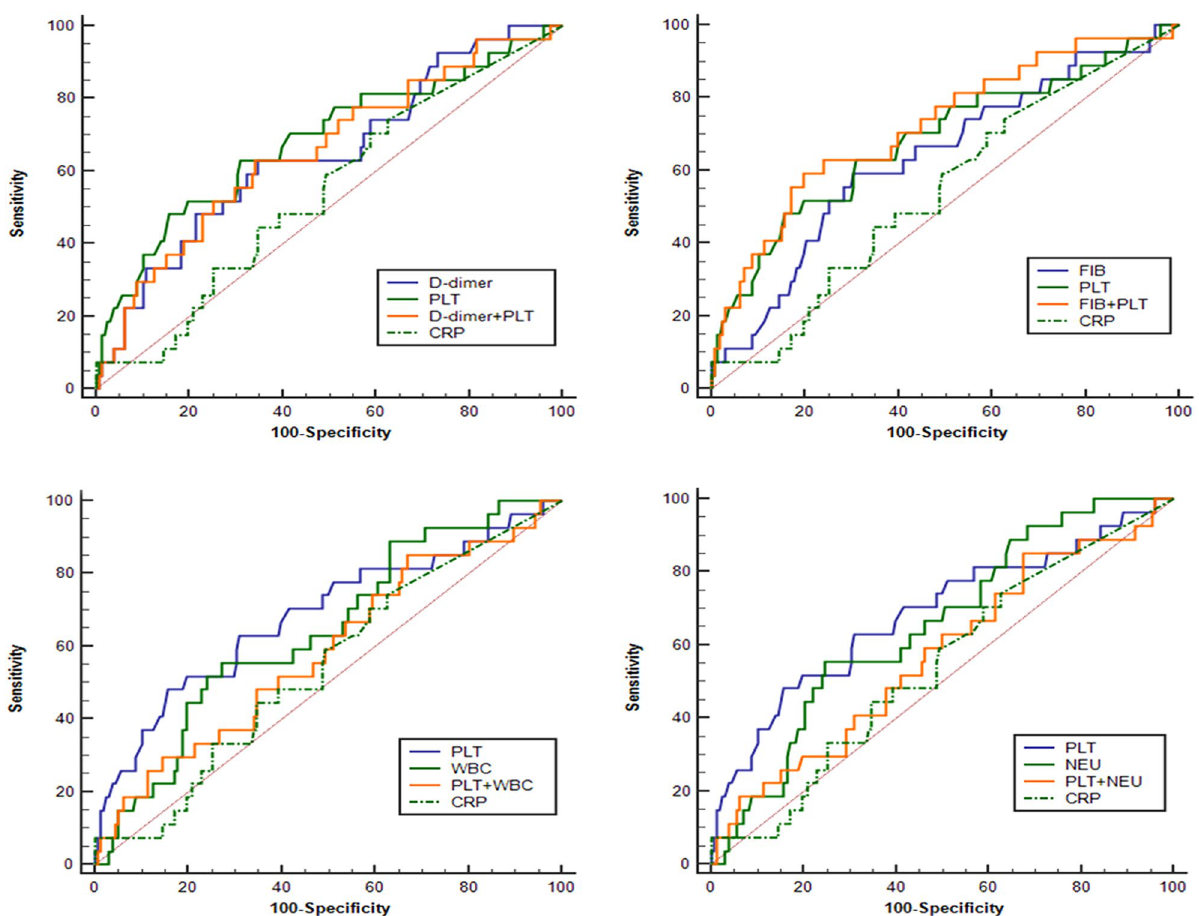
Figure 1. ROC curve of a single index of D-dimer, FIB, PLT, CRP, WBC, or NEU, and the combination of the single index and PLT for predicting in-hospital deaths in patients with type A AAD. ROC, receiver operating characteristic; FIB, fibrinogen; PLT, platelet; CRP, C-reactive protein; WBC, white blood cells; NEU, neutrophil; AAD, acute aortic